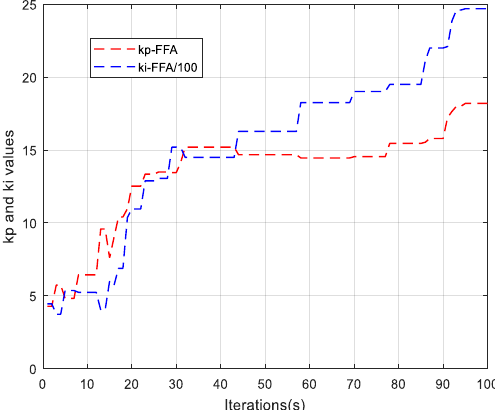
Figure 17. Evolution of parameters of FFA_PI until convergence.